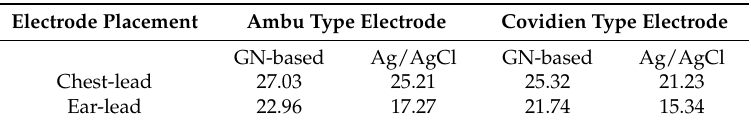
Table 2. Signal-to-noise ratios (SNRs) of electrocardiography (ECG) signals obtained with different electrodes and placements.